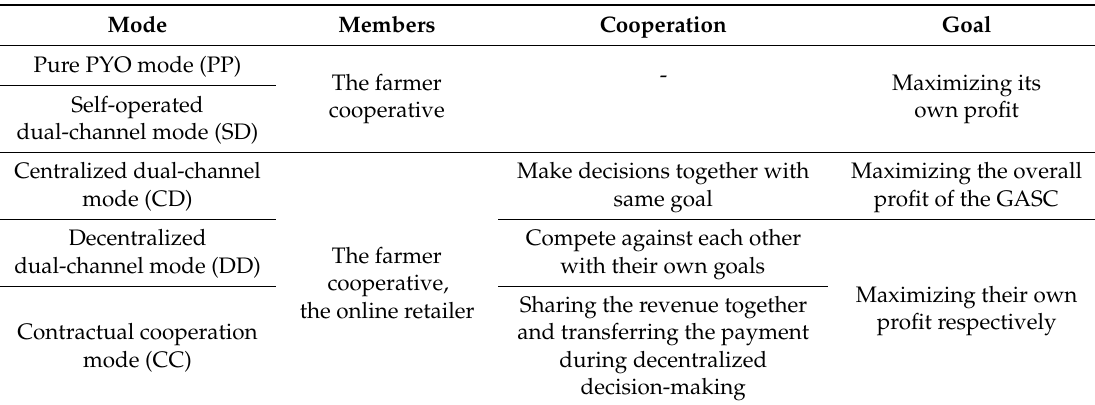
Table 2. Assumptions of five